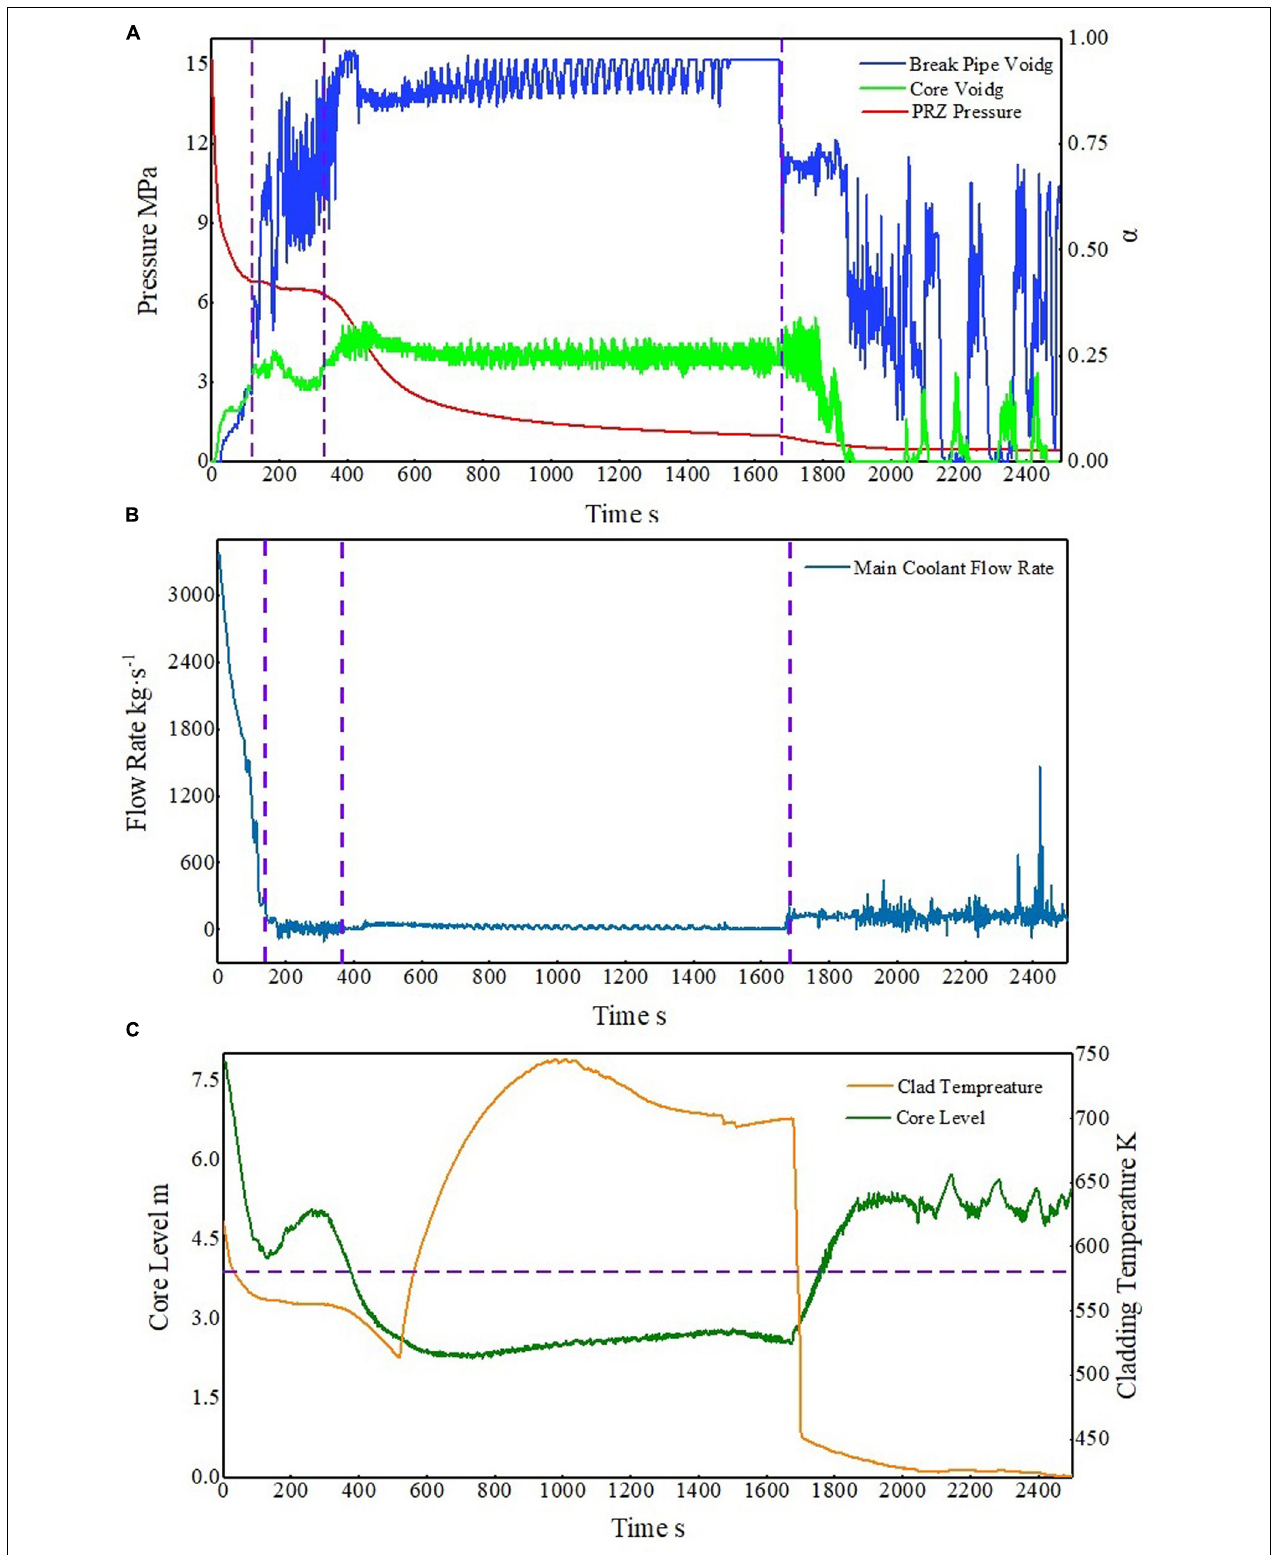
FIGURE 5 | The process of small-break loss-of-coolant accident (SBLOCA). (A) Trends in pressure and quality of gas mixture. (B) Trends in main flow rate. (C) Trends in core level and clad temperature.